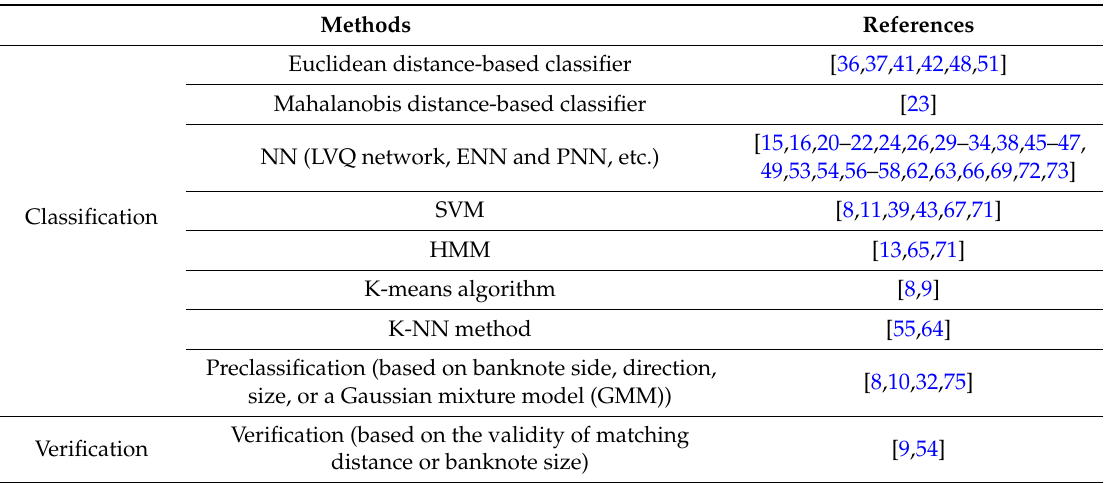
Table 4. Studies on classification and verification in the banknote recognition process flow.